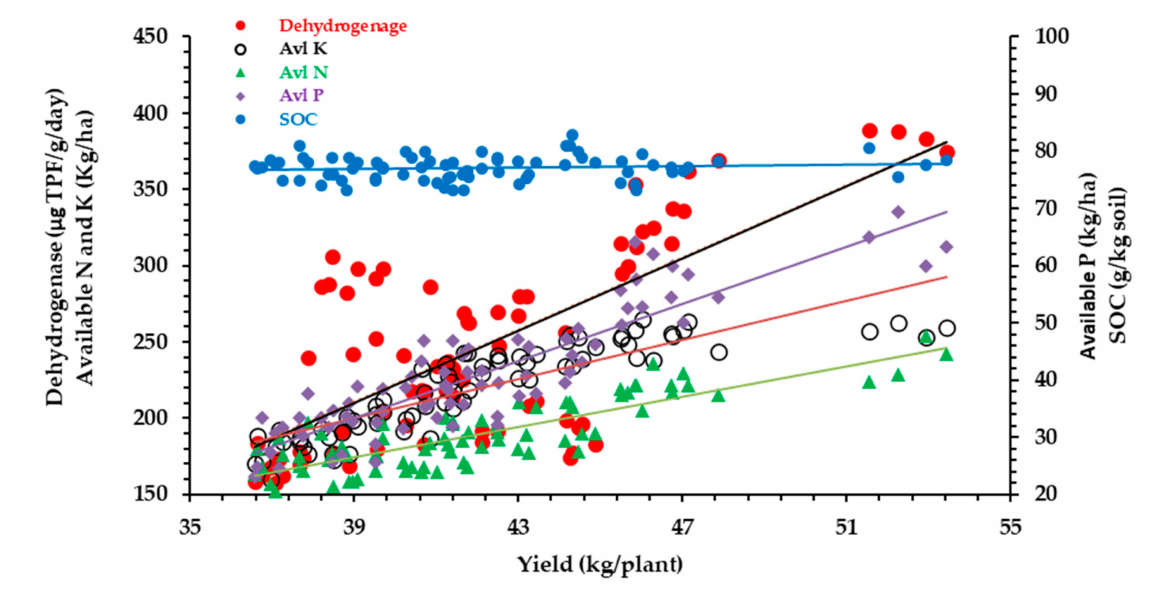
Figure 4. Correlation of soil properties as augmented by management practices with fruit yield ( p < 0.05, n =